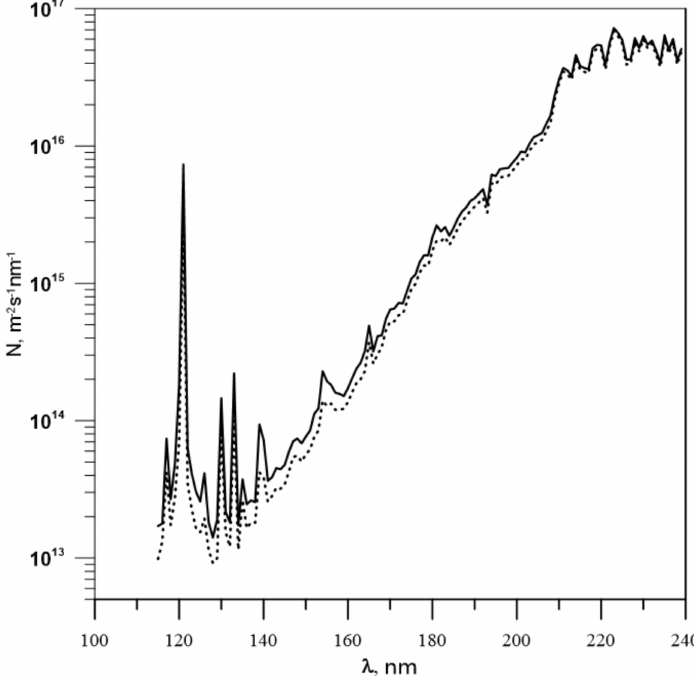
Figure 8. Model spectra for extreme values of the N L α